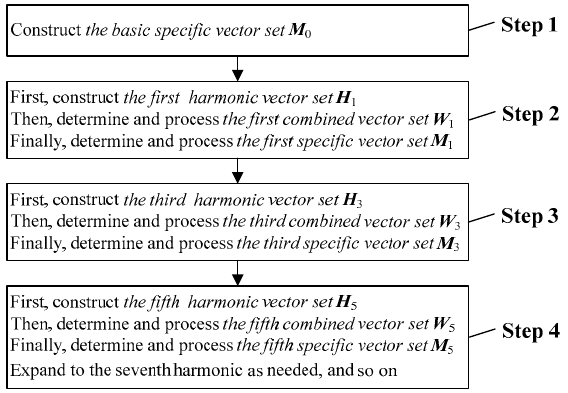
Figure 6. Flow chart of constructing the coordinate transformation matrix.